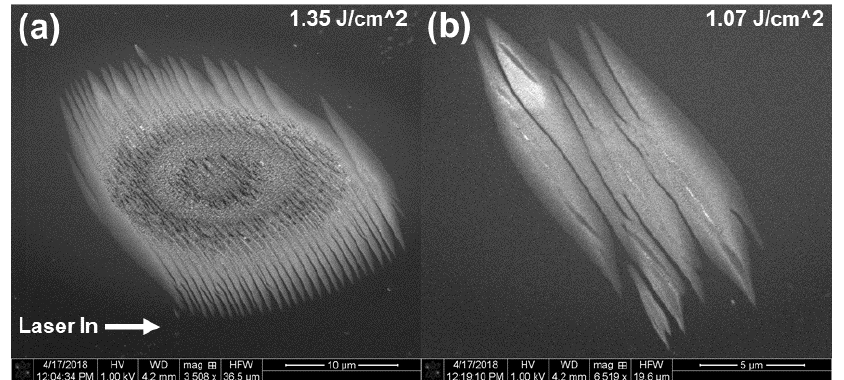
Figure 8. SEM images of multi-shot LID on silicon (111) with 500 shots and circular polarization. The fluence for each shot is indicated in the top right corner and the laser input direction is indicated in ( a ).